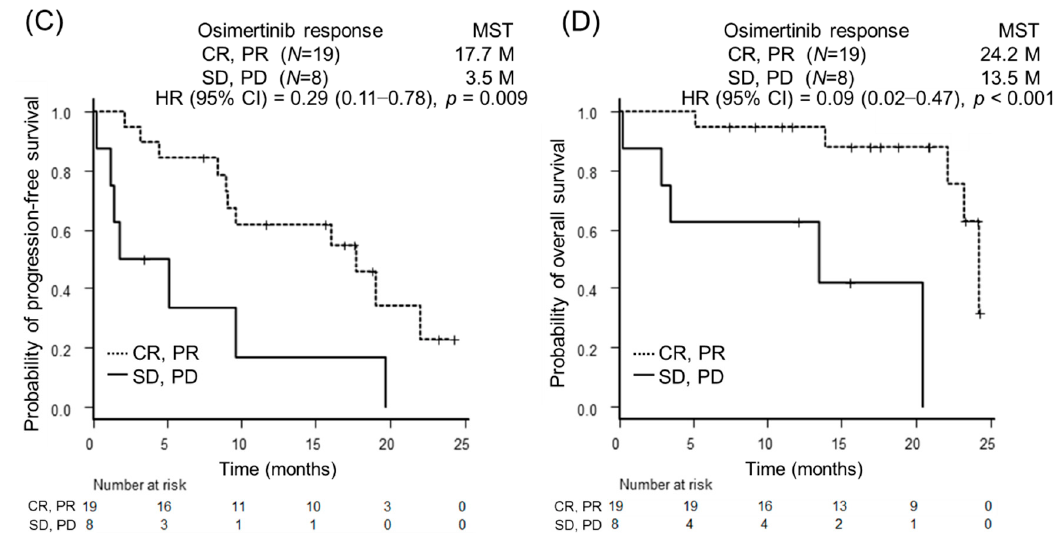
Figure 1. Kaplan-Meier survival curves for progression free survival (PFS) and overall survival (OS) for the PFS duration of initial EGFR-TKI treatment and osimertinib response. ( A , B ) PFS and OS of the EGFR -T790M-mutant non-small cell lung cancer (NSCLC) patients with the long PFS for the initial EGFR-TKI ( N = 20) or those with the short PFS ( N = 7). The median PFS was significantly longer in patients with the long PFS for the initial EGFR-TKI than in those with the short PFS (17.7 months versus 3.2 months, p = 0.021). There was no significant difference in OS between the two groups ( p = 0.337). ( C , D ) PFS and OS of EGFR -T790M-mutant NSCLC patients with osimertinib responsiveness (CR/PR) ( N = 19) or those with osimertinib non-responsiveness (SD/PD) ( N = 8). The median PFS and OS were significantly longer in osimertinib responders than in osimertinib non-responders (17.7 months versus 3.5 months, p = 0.009), (24.2 months versus 13.5 months, p = 0.021), respectively.